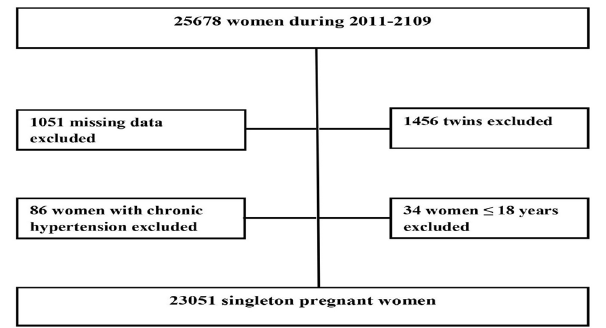
Figure 1. Flow chart of study